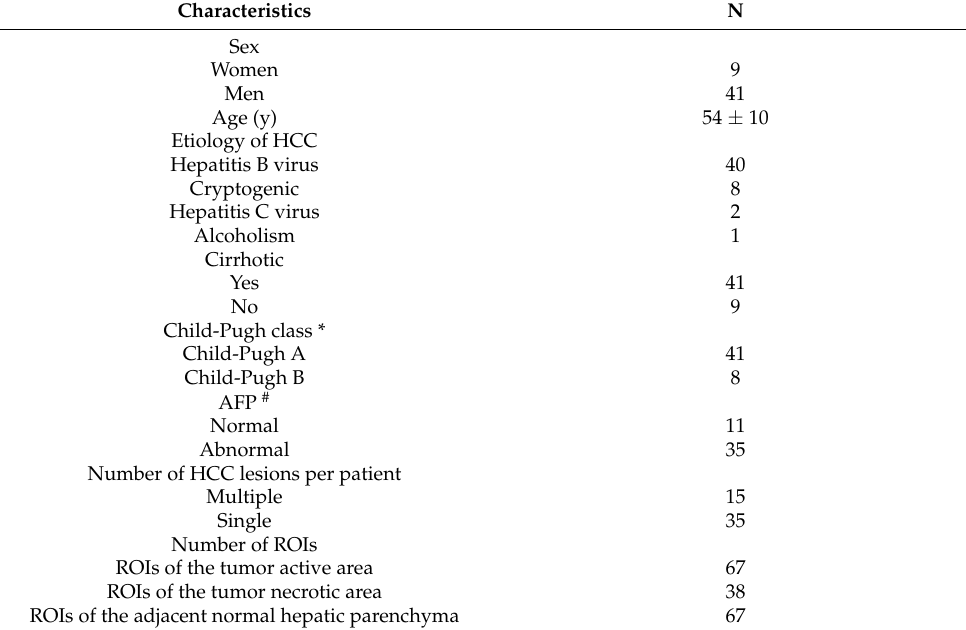
Table 2. Patient and lesion characteristics on IVIM.